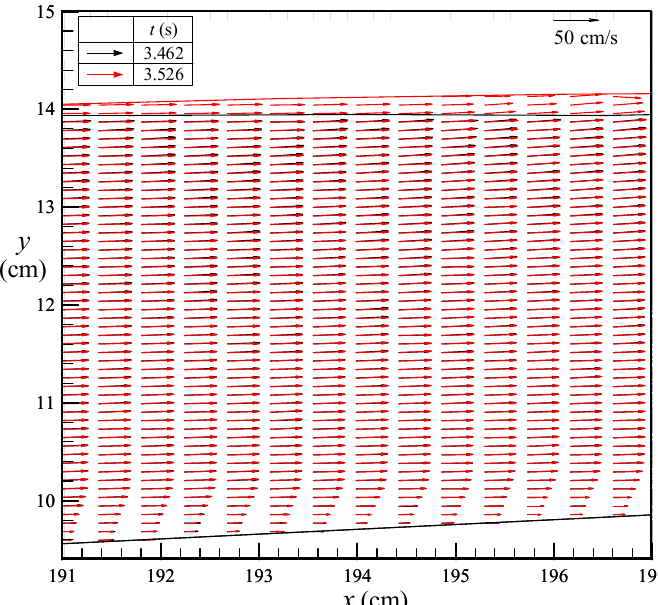
Figure 10. Velocity fields for 191.0 cm ≤ x ≤ 197.0 cm at t = 3.462 and 3.526 s (marked by black and red arrows), corresponding to zero-up-crossing and crest phases of 5th leading wave during run-up motion of generated bore.